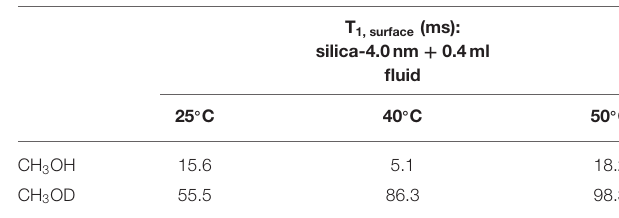
TABLE 7B | T 1,surface values of CH 3 OH and CH 3 OD in confined